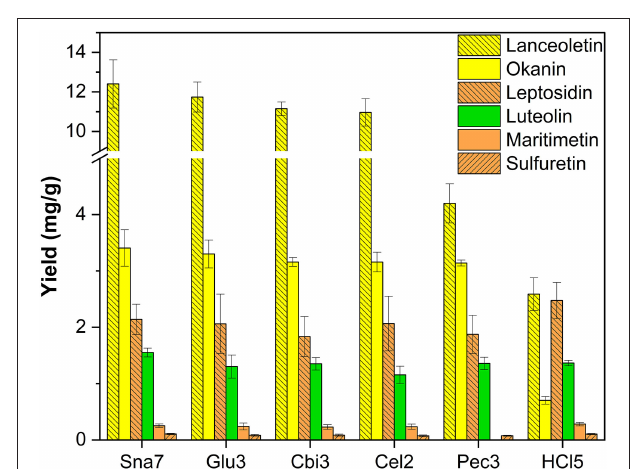
FIGURE 4 | Aglycone yields (mg/g) from flower extracts of C. grandiflora . Enzymatic hydrolysis (25min): Sna7: 5mg snailase (pH 5.5, 37 ◦ C); Glu3: 20U β -glucosidase (pH 5.5, 37 ◦ C); Cbi3: 5U cellobiase (pH 4.5, 37 ◦ C); Cel2: 20U cellulase (pH 6.0, 52 ◦ C); Pec3: 20U pectinase (pH 4.5, 40 ◦ C). Acidic hydrolysis (60min): HCl5: 1M HCl at 100 ◦ C ( n = 3 ± SD).